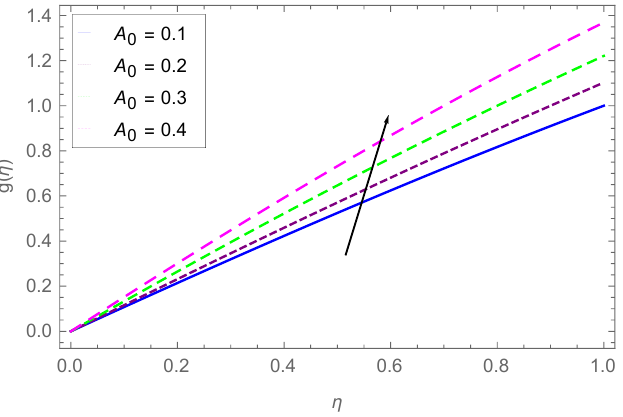
Figure 15. Graph depicting g ( η ) dependence on A 0 . The impact of the nanofluid volume fraction parameter on the axial velocity f ( η ) is displayed in Figure 16. It is clear from the figure that at intermediate values of the independent variable ( η = 0.5), the velocity profile declines at a rapid rate as compared to the boundary values. Physically, when the nanoparticle volume fraction increases, the mass per unit volume also increases, and as a result, when the nanofluid volume fraction increases from 0.01 to 0.04, the axial velocity profile declines.